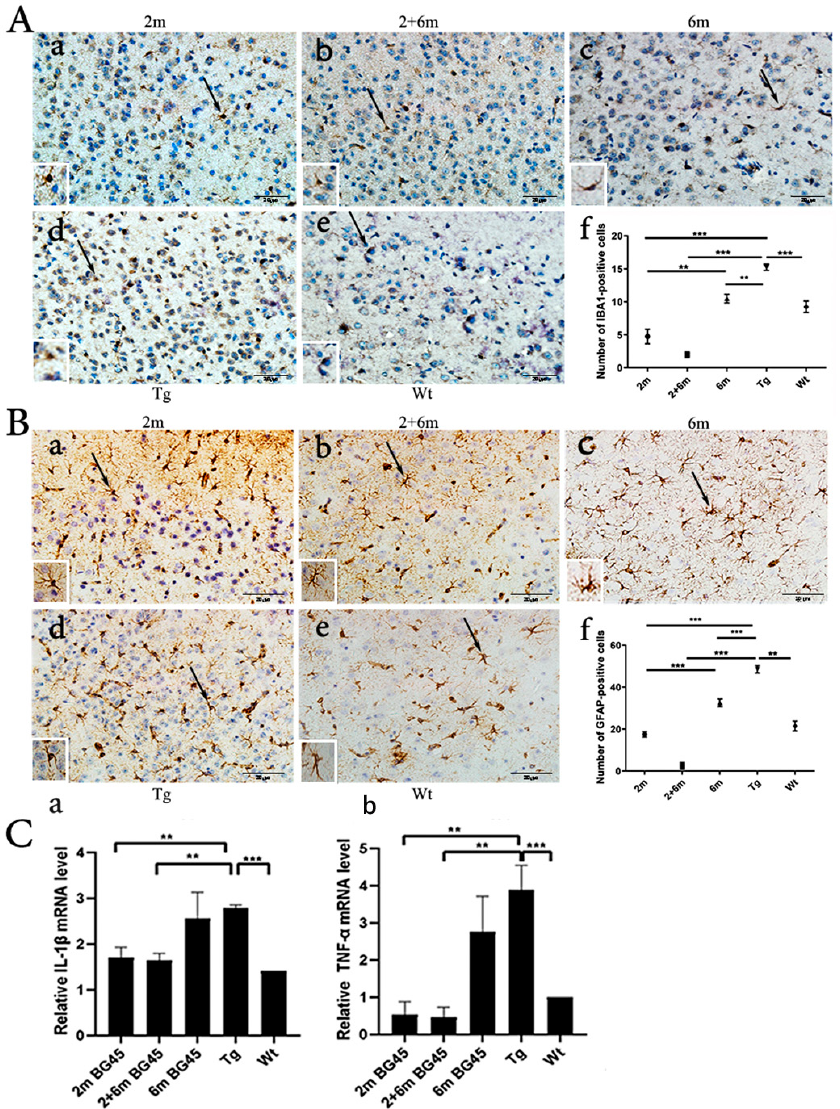
Figure 7. BG45 decreased the numbers of microglia and astrocytes and mRNA levels of inflamma- tory cytokines in the entorhinal cortexes of the APP/PS1 mice. ( Aa – f ) Photographs and quantitative statistical analyses of microglia in the entorhinal cortex samples. ( Ba – f ): Photographs and quantitative statistical analyses of astrocytes in the entorhinal cortex samples. *** p < 0.001 and ** p < 0.01. ( Ca , b ) mRNA levels of IL-1 β and TNF- α in the entorhinal cortex samples. *** p < 0.001 and ** p < 0.01. All values are presented as the means ± SDs from three independent experiments. n = five mice per group.